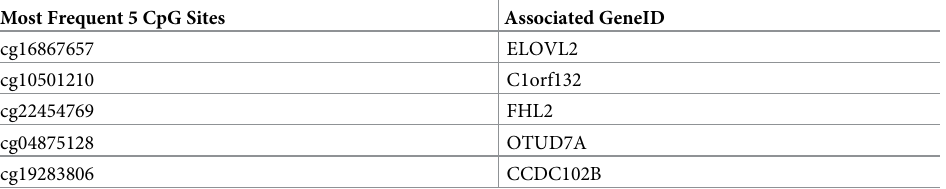
Table 2. The five CpG sites that are chosen as most frequent predictors for aging and their associated gene symbols.